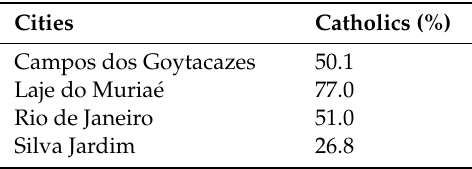
Table 1. Proportion of Catholics in the Selected Municipalities in the State of Rio de Janeiro.